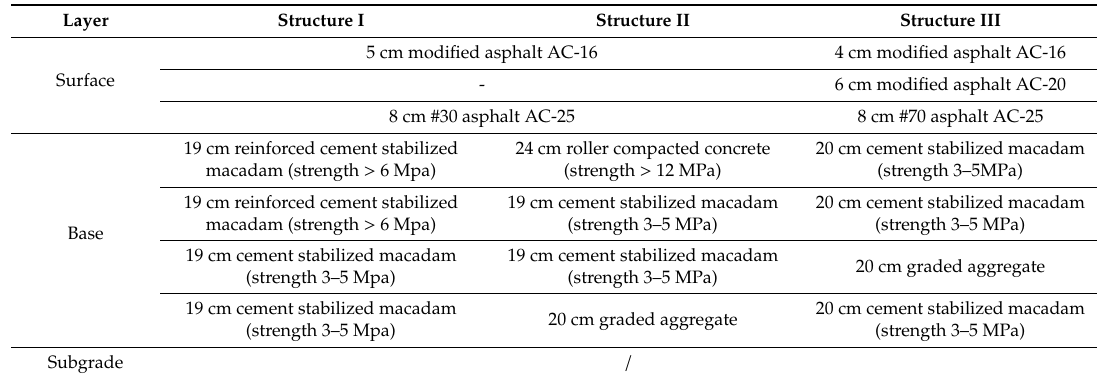
Table 1. Pavement types.